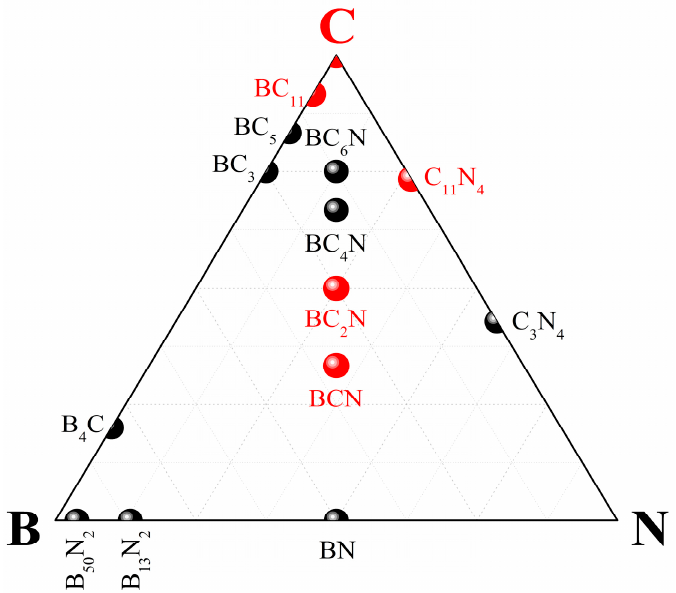
Figure 1. Superhard phases of the B–C–N ternary system. Ultrahard phases discussed in the present paper are shown in red.